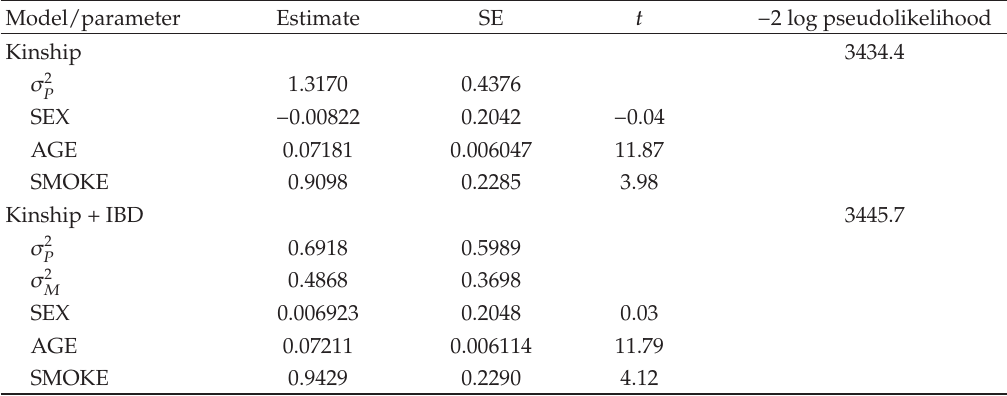
Table 3: AFFECTED and VEGFC under a logistic model.